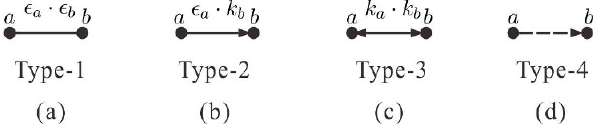
Figure 3 . Four types of lines in the re(cid:12)ned graphic rule for multi-trace EYM